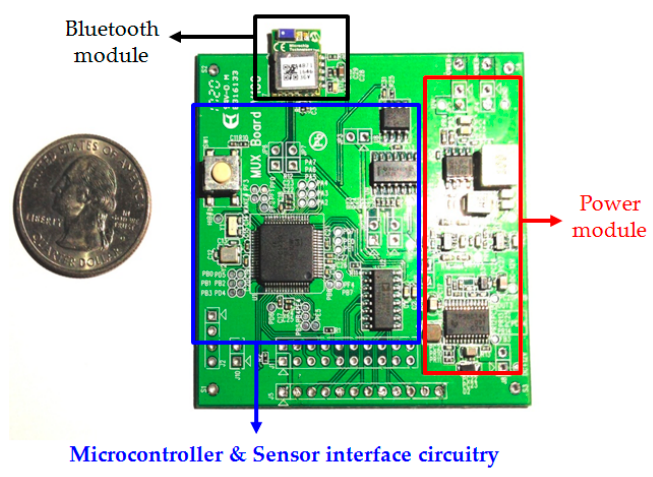
Figure 6. Designed wireless sensor readout module board.